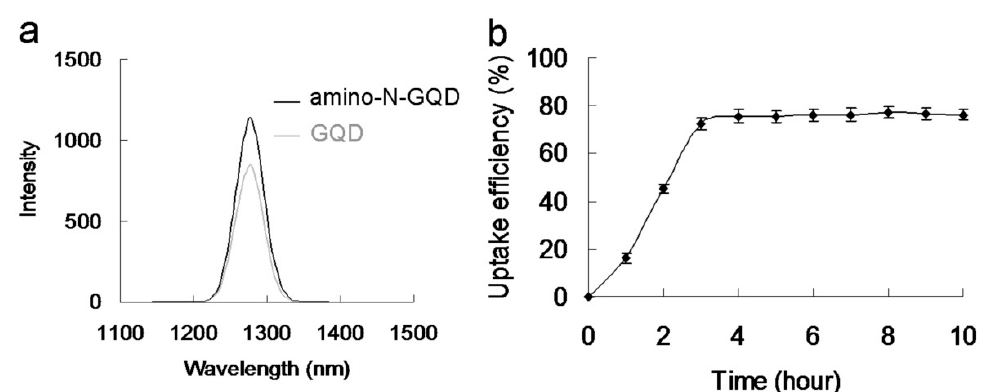
Figure 4. ( a ) Low-magnified TEM image; ( b ) HR-TEM image of a single GQD exhibiting the graphene {1 1 − 00} lattice plane (mean lateral size = 8.0 nm; d -spacing = 0.213 nm); the size distribution of its histogram was determined using DLS (Figure S1b). ( c ) XRD spectrum of GQDs, indicating a diffraction angle 2 θ of nearly 24.3° and revealing a well-ordered lamellar structure with favorable layer regularity and an interlayer distance of 0.360 nm. ( d ) UV-vis spectrum of GQDs. The peak at 211 nm corresponds to the π → π * transition of aromatic C=C bonds, whereas that at 312 nm corresponds to the n → π * transitions of the C=O shoulder. ( e ) Raman spectrum of GQDs. The gray and brown lines indicate the spectrum decom- posed and fitted to D- and G-band peaks (at ~1383 and 1607 cm − 1 , respectively; black line: raw data; pink line: decomposed spectrum). The I D/ I G integrated intensity ratio was 0.89. The diameter obtained from the Raman calculations (Equations (S2) and (S3)) was approximately 7.8 nm. The estimated size almost matched that obtained from the HR-TEM calculations. ( f ) Deconvoluted C(1s) XPS spectra with Gaussian function-fitted peaks: nonoxygenated ring (C–C/C=C, 285.8 eV), hy- droxyl (C–O, 286.9 eV), carbonyl (C=O, 288.1 eV), and carboxylate (O=C–O, 289.0 eV) groups. The table summarizes the bonding composition and atomic ratio of the GQDs. Delivered dose: from 0.5 μ g·mL − 1 to 5 mg·mL − 1 material.